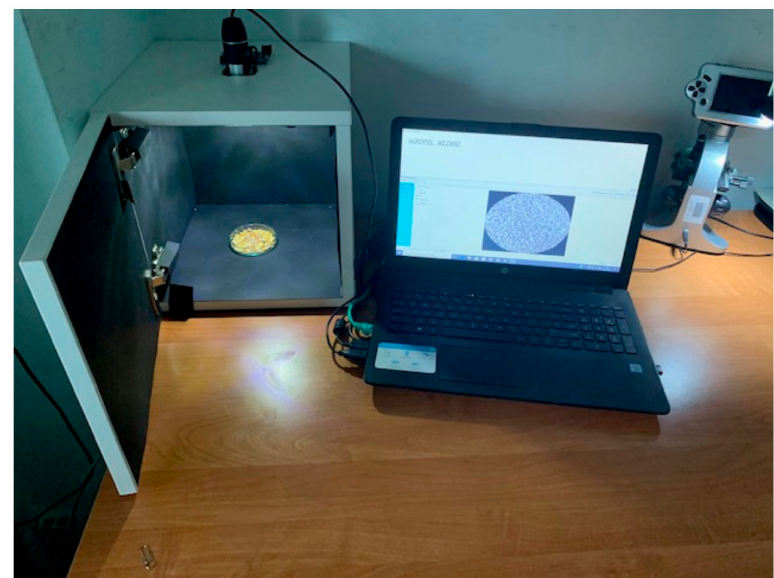
Figure 2. The computer image analysis stand. [Source: Katarzyna